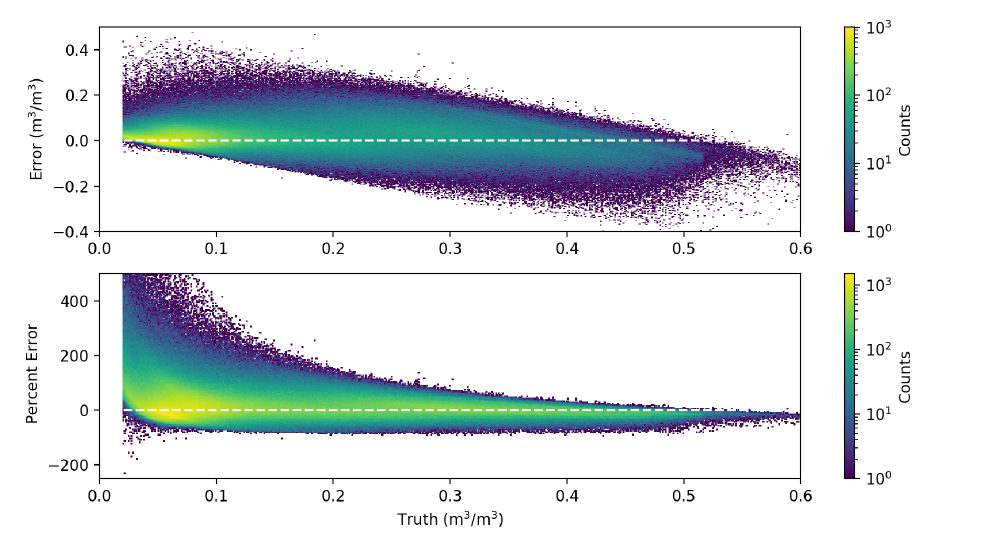
Figure 10. Error ( top ) and percent error ( bottom ) between target and prediction as function of target value for same run as shown in Figure 9.